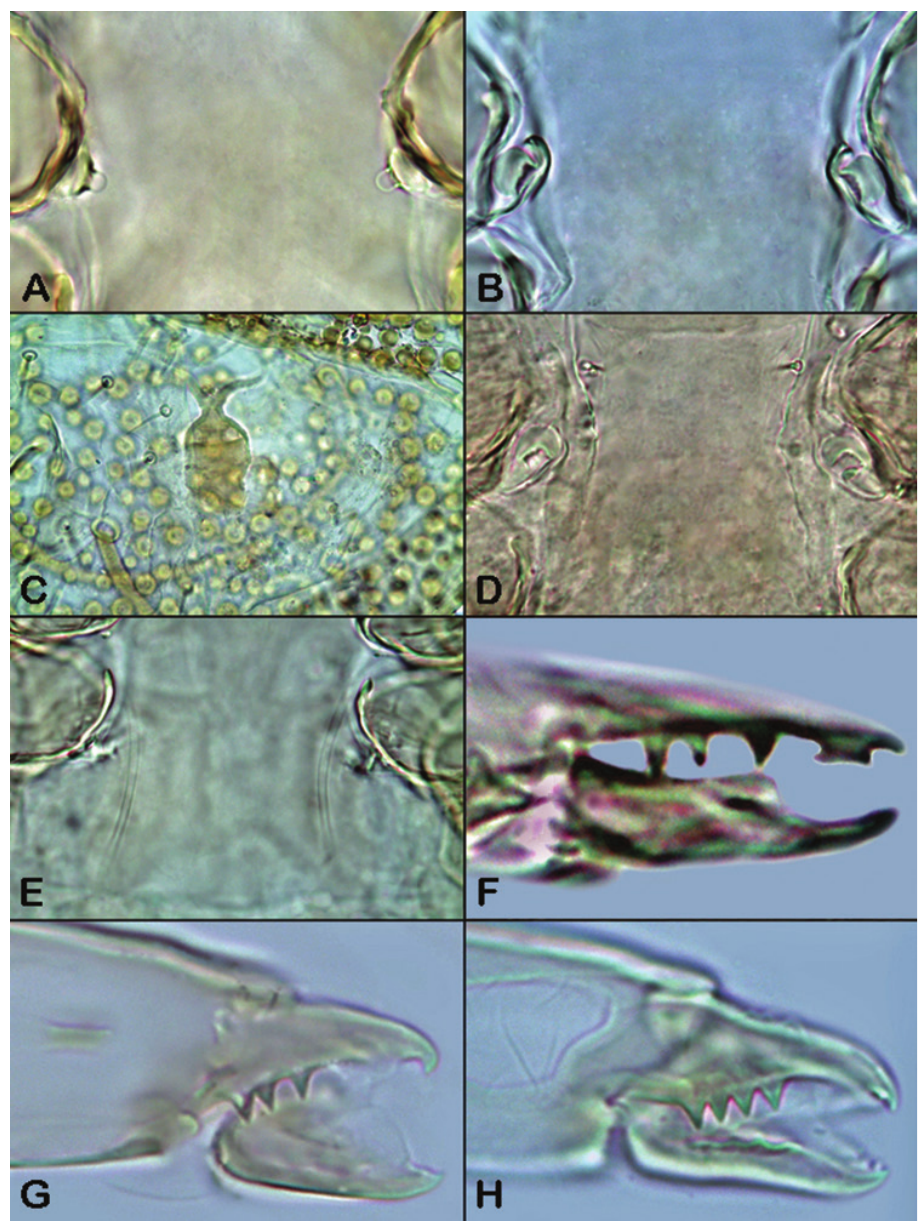
Plate 76. Ameroseiidae spp., female. A–E Structures of sperm access system. A Kleemannia delicata , sperm induction pores (solenostomes) associated with inner margin of coxae III B and D Kleemannia plumigera , solenostomes associated with inner margin of coxae III C Epicriopsis suedus , sacculus foemineus and associated tubuli annulati E Sertitympanum nodosum , tubuli annulati F–H Chelicera. F Asperolaelaps rotundus G Ameroseius renatae H Kleemannia delicata